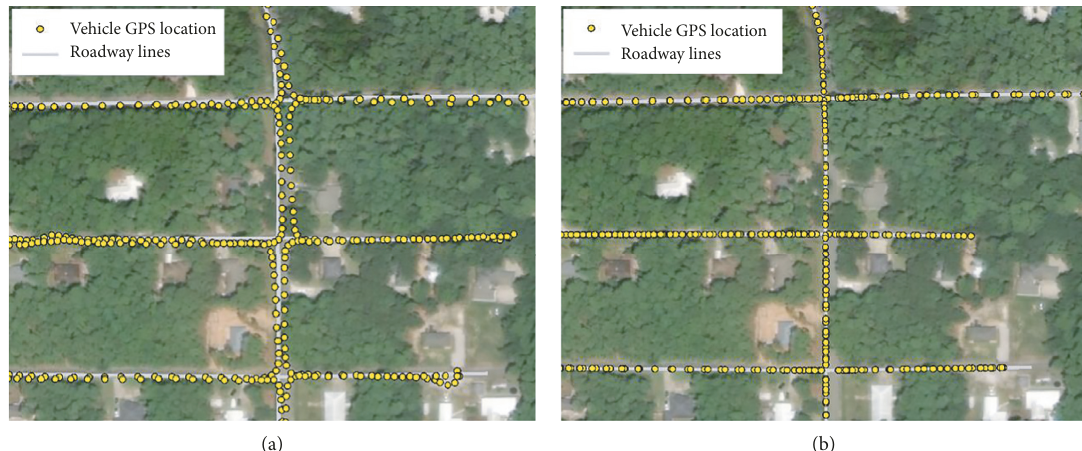
Figure 3: Geolocated GPS points (a) before being snapped to roadway lines and (b) after being snapped to roadway